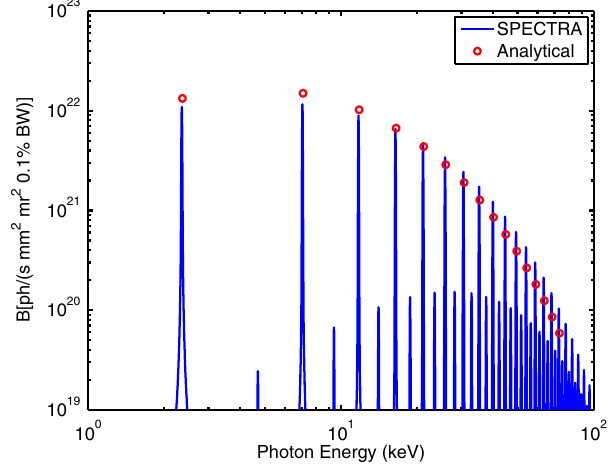
FIG. 4. Spectral brightness of PEP-X at 200 mA, calculated using SPECTRA and the formula [Eq. (2.5)] multiplying by the reduction factor [Eq. (2.16)].